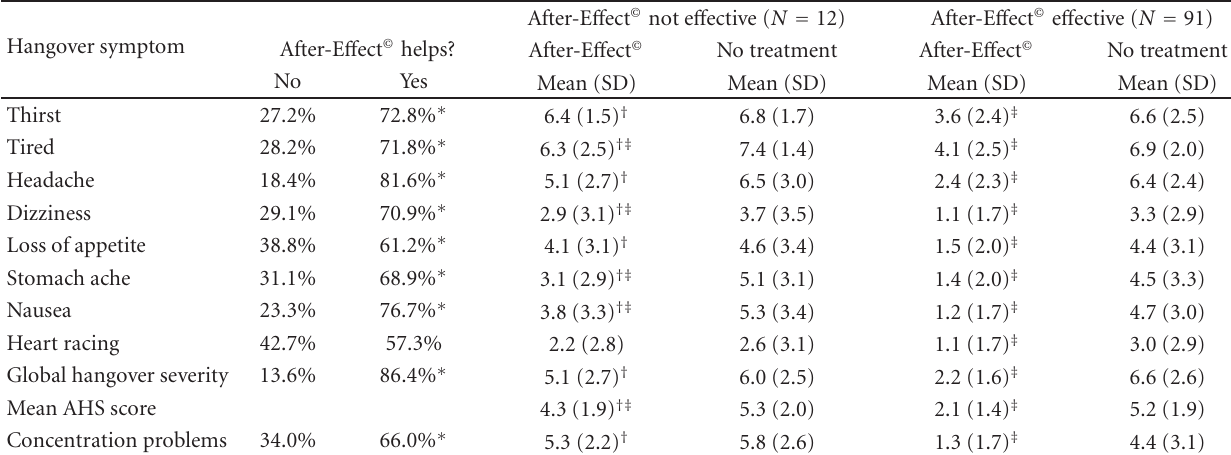
Table 3: Reported consumer satisfaction on the e ffi cacy of After-E ff ect © to reduce hangover symptoms. Hangover